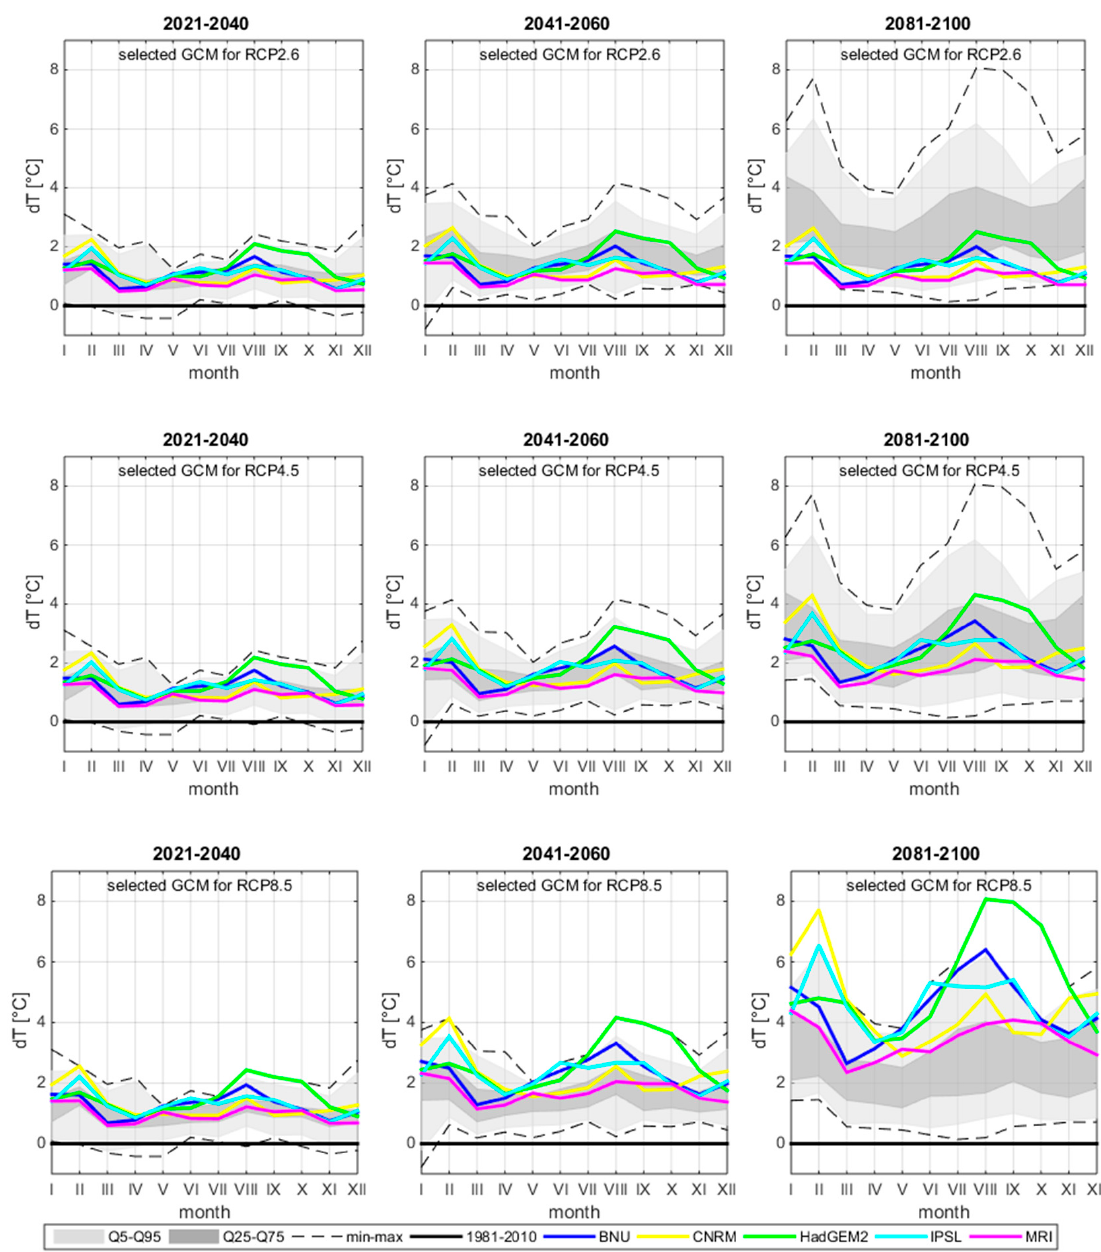
Figure 3. Uncertainty of the estimated monthly air temperatures for individual time horizons (columns). The 90% (Q5–Q95) and 50% (Q25–Q75) confidence intervals are calculated for the ensemble of all 34 model outputs. The GCM models from the CMIP5 model for selected RCP emission scenarios (rows) are marked in color.